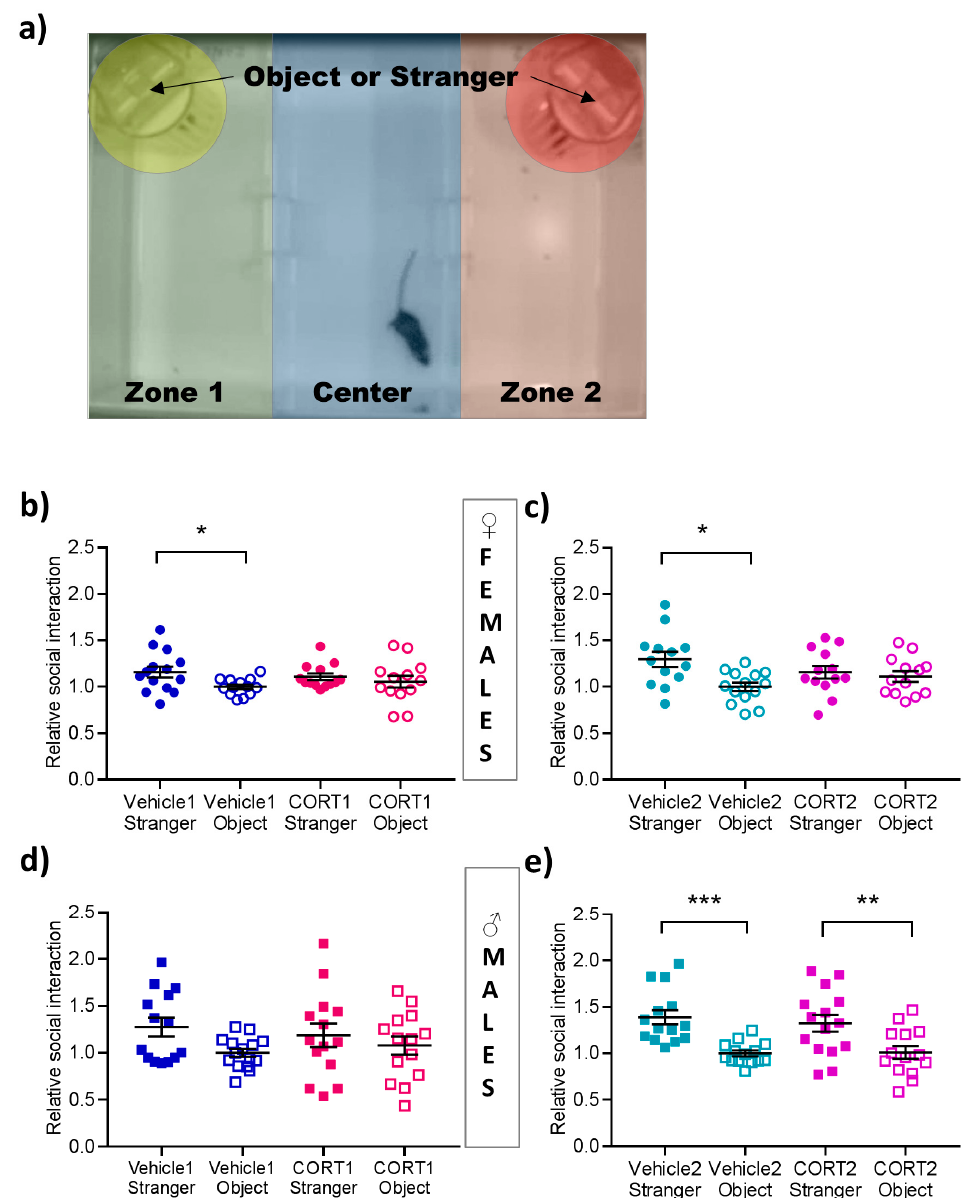
Figure 4. Social Interaction test in CORT mice. ( a ) Experimental design and behavioral results of social interaction test in ( b – c ) female and ( d – e ) male CORT treated and Vehicle control mice. All values are presented as mean ± SEM ( n = 13–15 per group). Statistical significances displayed results of posthoc pairwise comparison after repeated measure ANOVA. * p < 0.05, ** p < 0.01, *** p < 0.001.